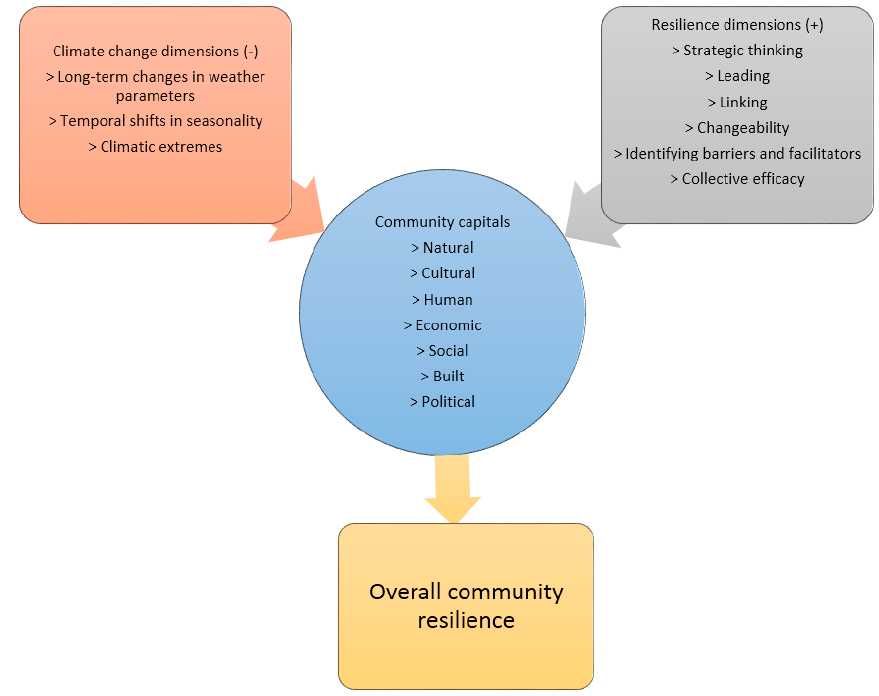
Figure 2. A conceptual model for climate change, community resilience and community capitals.